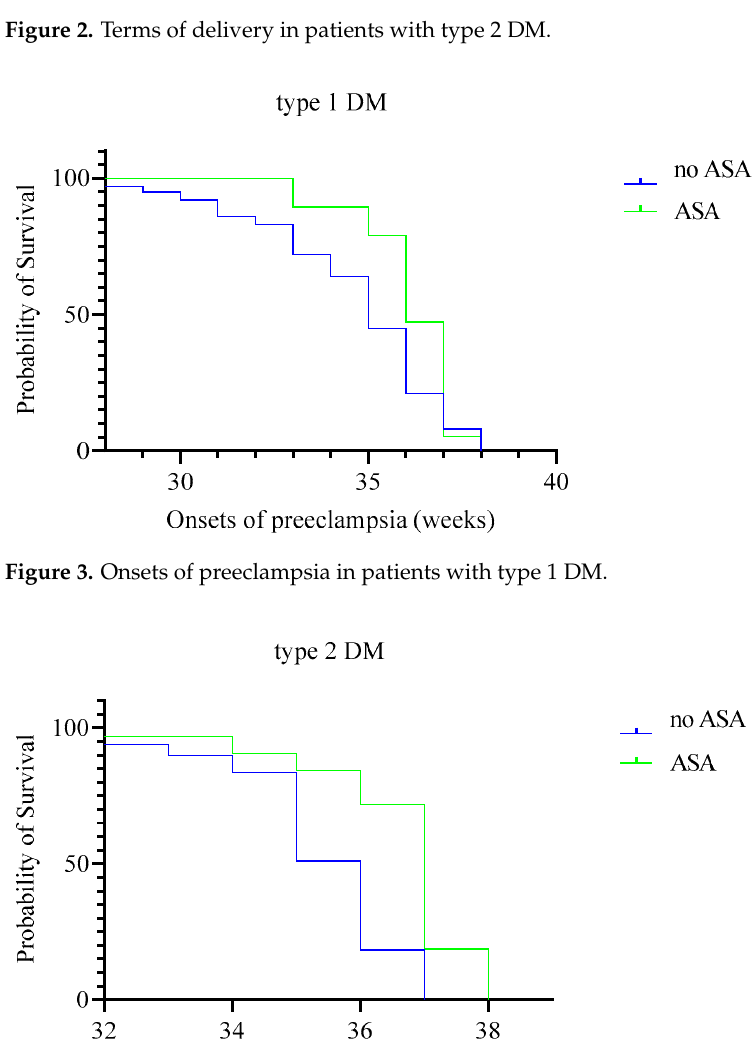
Figure 2. Terms of delivery in patients with type 2 DM.